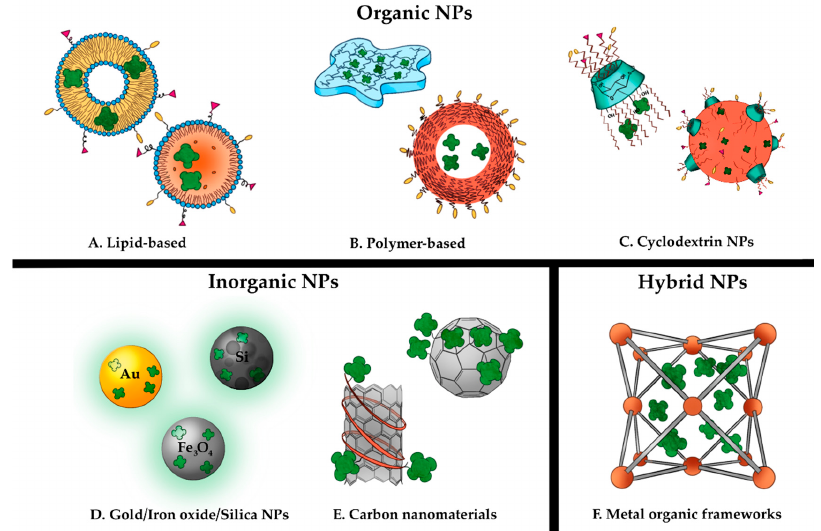
Figure 2. Types of nanoparticles (NPs) that have been used to improve PS (depicted by green) solubility, bioavailability and tumor targeting: ( A ) lipid-based NPs (liposomes and solid lipid NPs), ( B ) polymer-based NPs (hydrogel and PNPs), ( C ) cyclodextrin NPs, ( D ) inorganic NPs (Au, Fe and Si-NPs), ( E ) carbon nanomaterials (carbon nanotubes and fullerene) and ( F ) metal organic